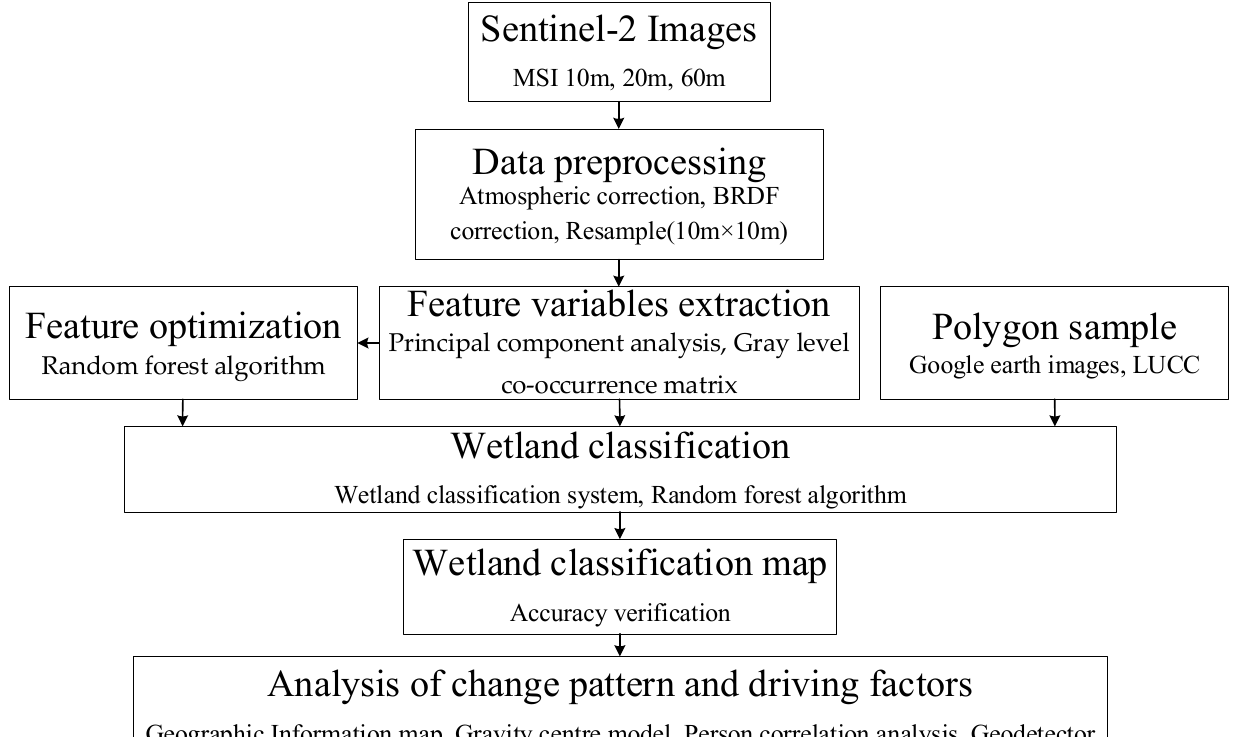
Figure 2. Overall technical flowchart of this study.